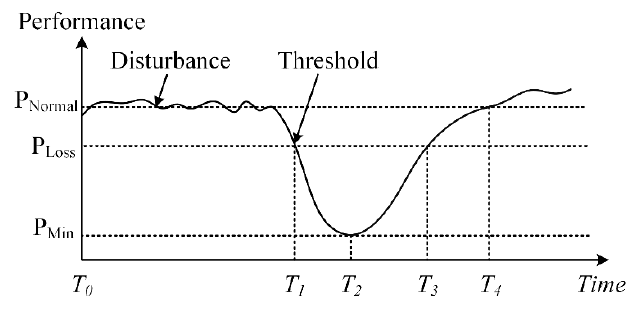
Figure 3. Temporal progress of absorptive, restorative, and adaptive capabilities in WDN resilience.